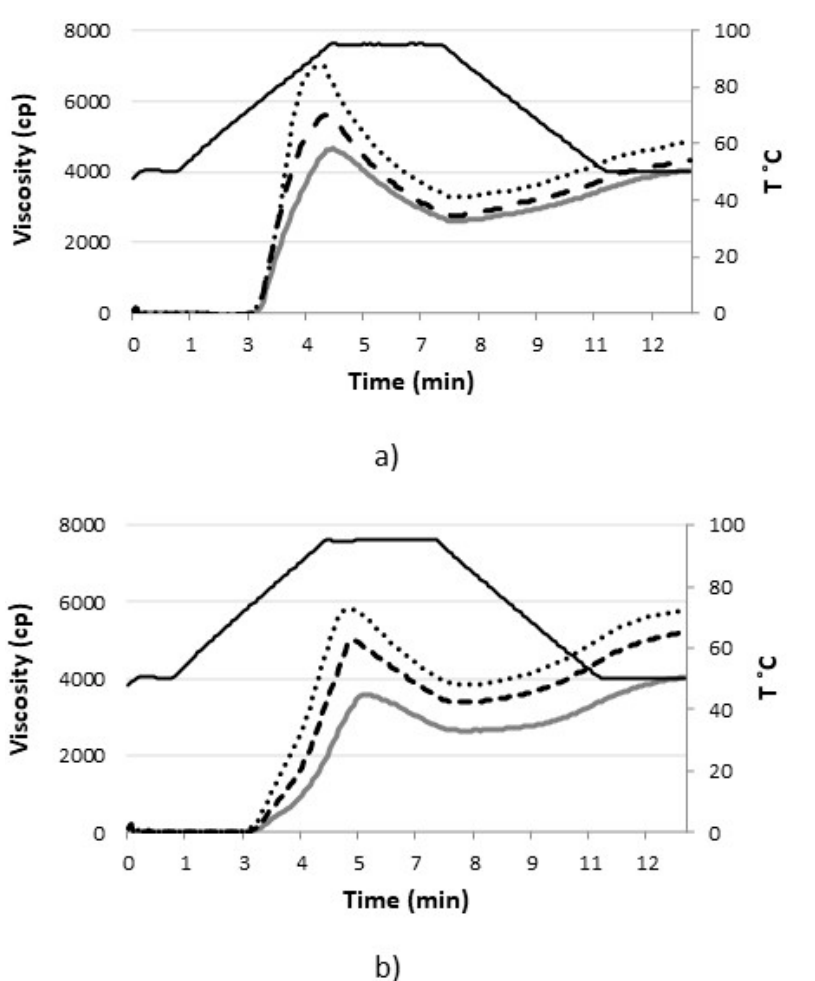
Figure 2. Pasting properties of flour/starches/fiber mixtures. ( a ) 40% maize starch/40% Rice Flour/20% Cassava Starch. ( b ) 80% maize starch/20% Cassava Starch. Solid black line: Temperature; Solid grey line: Control; Dashed line: Mixture with citrus fi ber; Do tt ed line: Mixture with activated citrus fi ber.